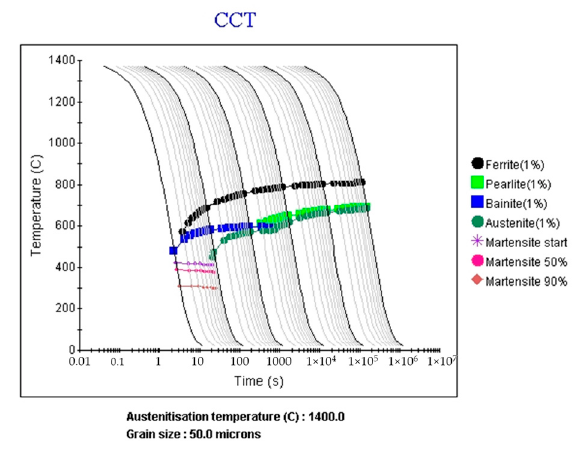
Figure 11. CCT diagram of SS400 steel at PAGS 50 µm.